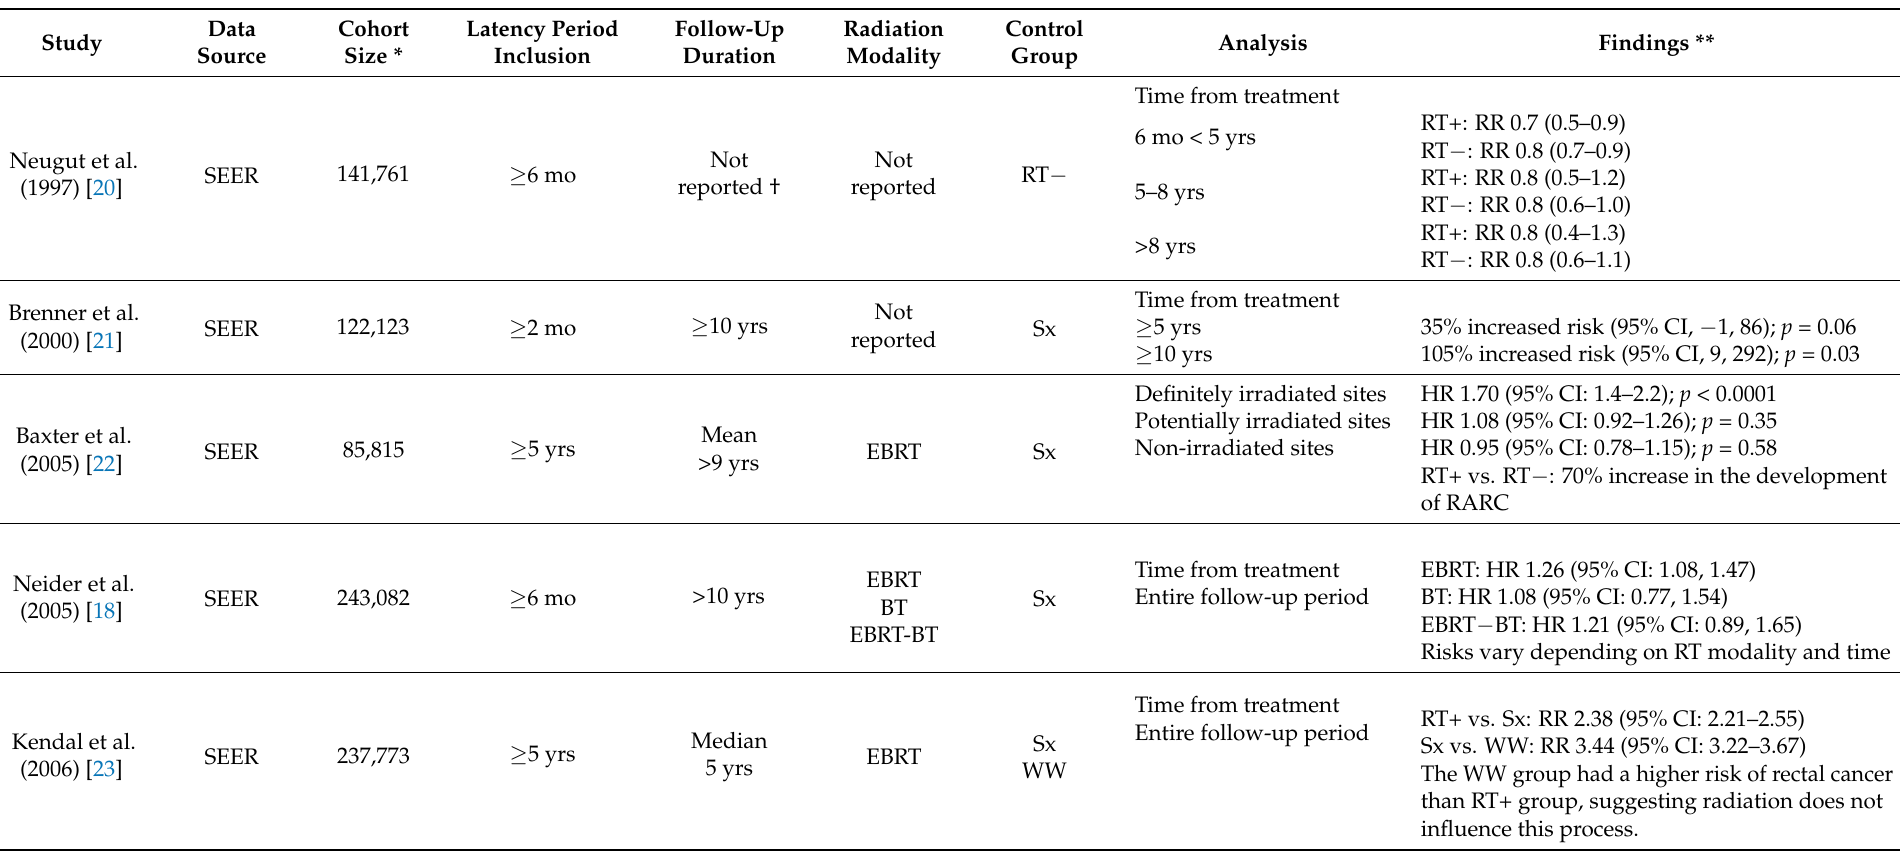
Table 1. A list of the literature reporting the incidence, risk, and survival of radiation-associated rectal cancer compared to non-irradiated patients [located below